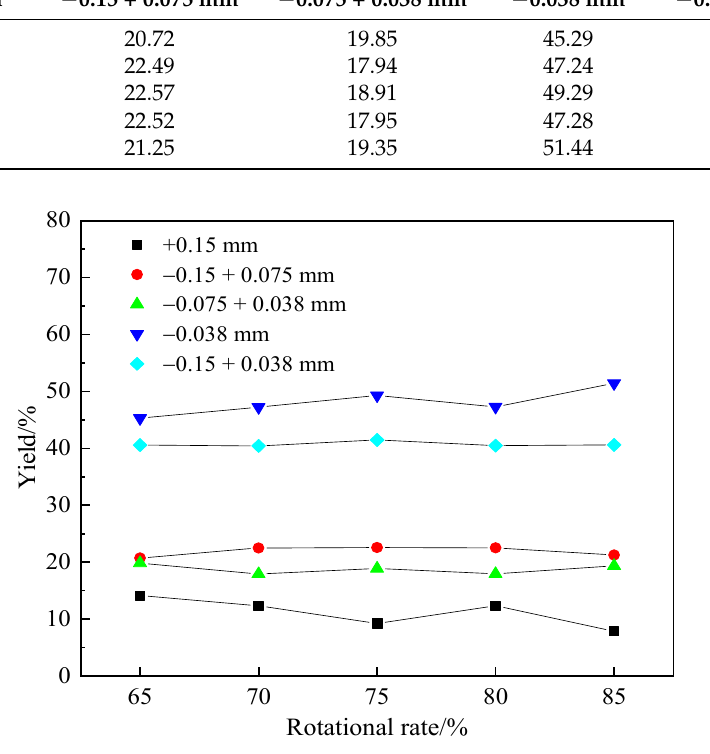
Figure 4. Particle size of grinding product at different rotational rates.